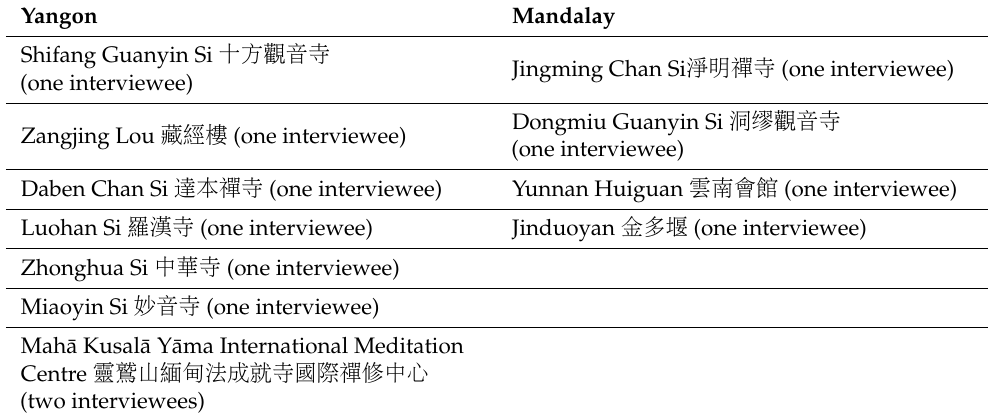
Table 1. Interview sites, by